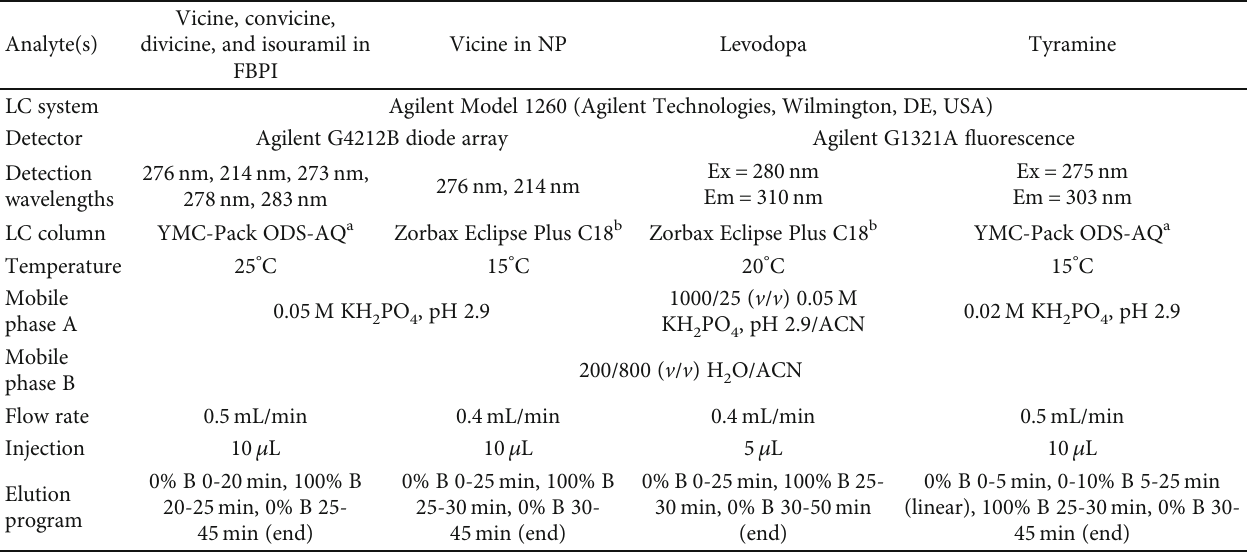
Table 1: HPLC instrumentation and